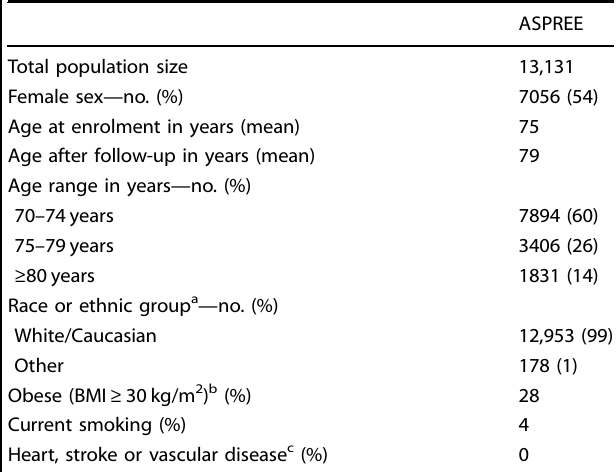
Table 1. Baseline characteristics of sequenced participants.